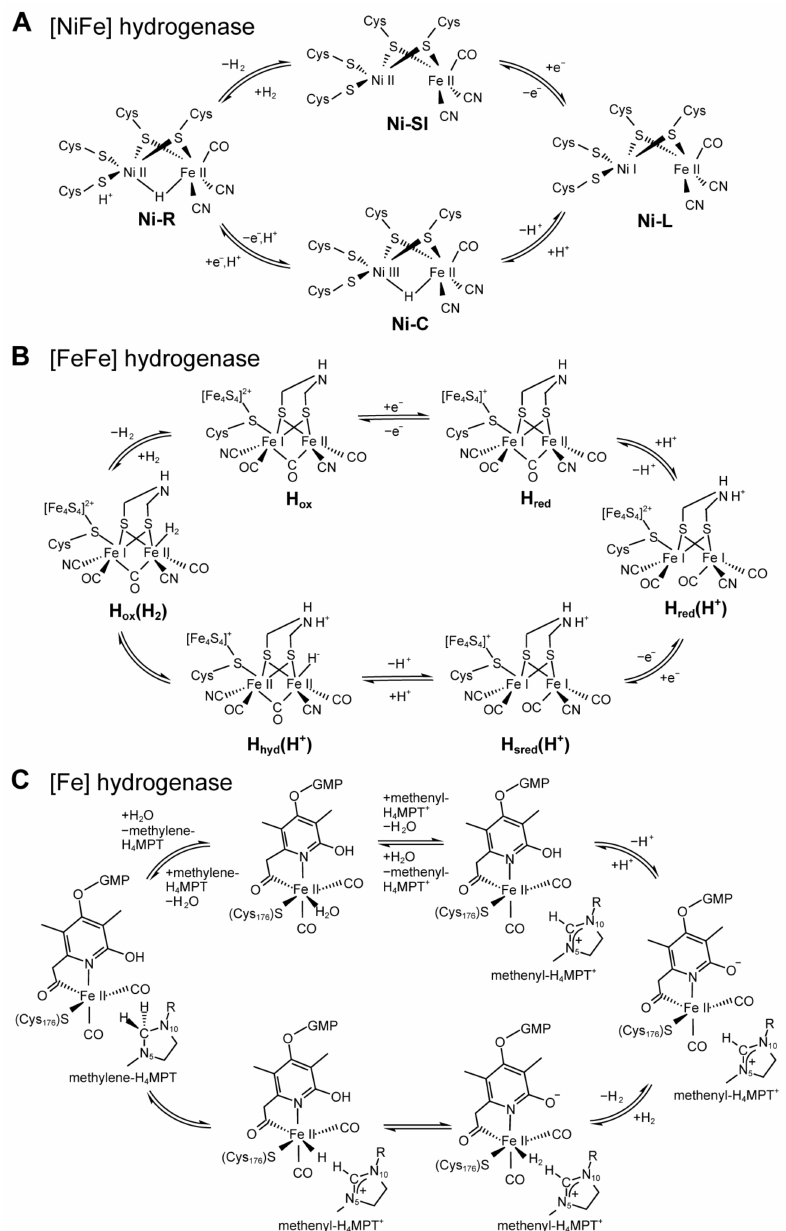
Figure 3. Catalytic mechanism of hydrogenases. ( A ) Catalytic cycle of [NiFe] hydrogenase [47]. ( B ) Catalytic cycle of [FeFe] hydrogenase [56]. ( C ) Catalytic cycle of [Fe] hydrogenase [57]. The small subunit of the standard [NiFe] hydrogenase contains the proximal and distal [4Fe–4S] clusters and the medial [3Fe–4S] cluster for electron transfer between the active [NiFe] site in the center and the surface of the protein [58]. The crystal